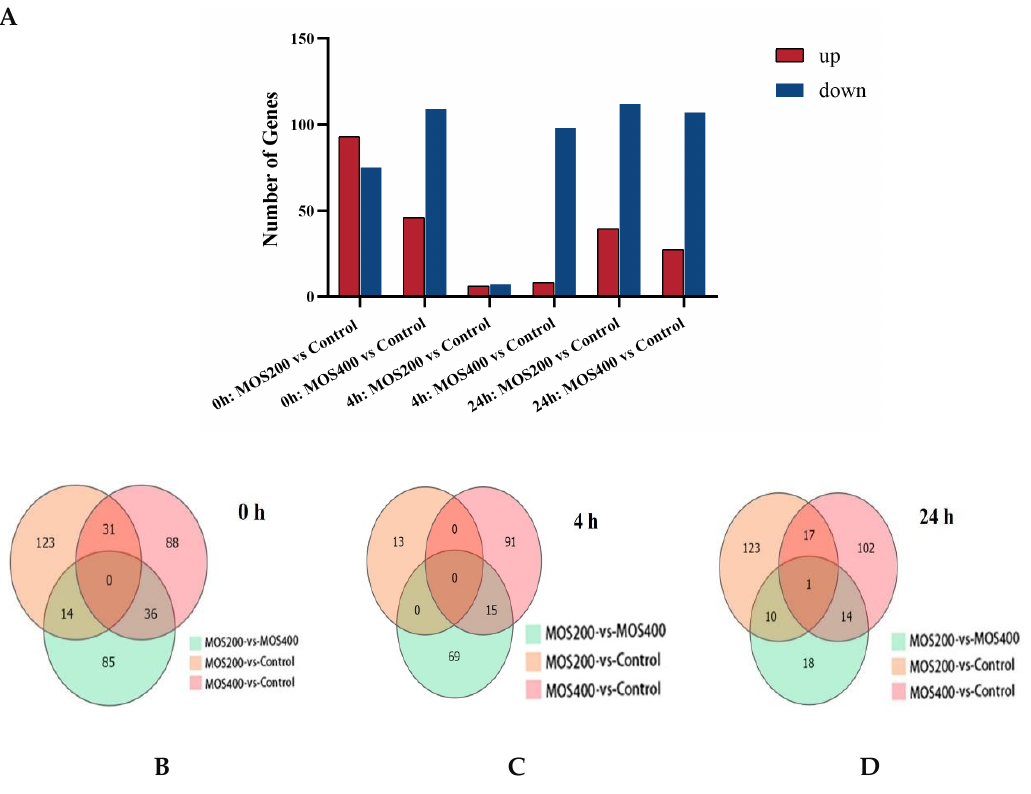
Figure 1. Statistics of differentially expressed genes (DEGs) at different time points upon infection.